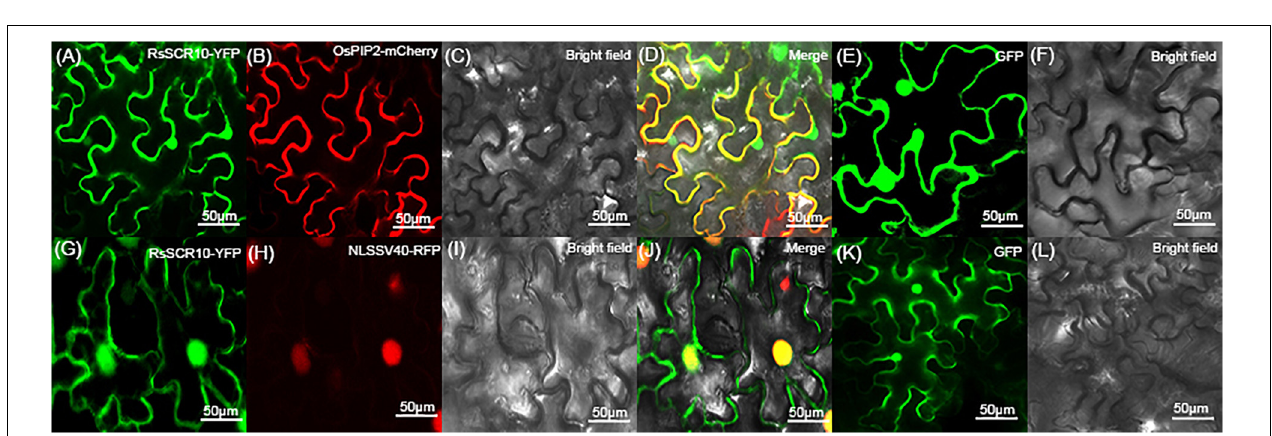
FIGURE 7 | Subcellular localization of RsSCR10 in tobacco epidermal cells. (A–D) The fusion protein (RsSCR10-YFP) was coexpressed with the plasma membrane marker (OsPIP2.1-mCherry) (Dangol et al., 2017). (G–J) The fusion protein (RsSCR10-YFP) was coexpressed with the nucleus marker (PR82:2 × RFP-NLSSV40) (Huang et al., 2014). (E,F,K,L) Subcellular localization of the control (GFP) in tobacco leaf epidermis cells. Images were captured 2–3 days postinfiltration. Bars, 50 µ m. All experiments were repeated at least three times.